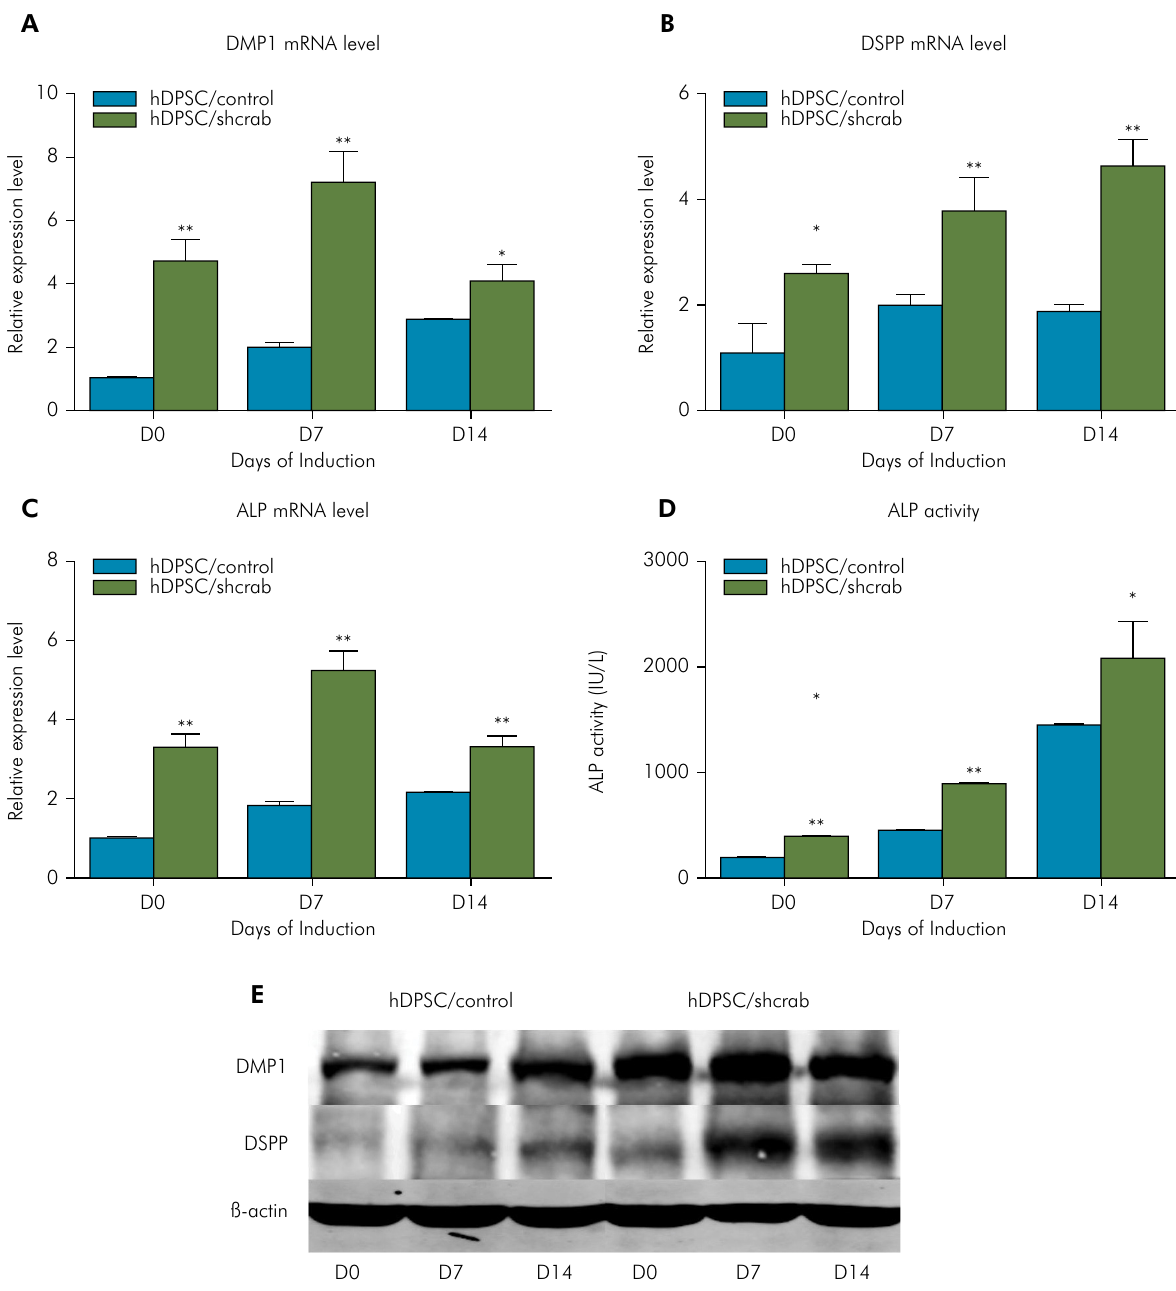
Figure 5. Inhibitory effect of CRABP2 on the odontoblastic differentiation of hDPSCs. A, B and C: mRNA level of DMP1, DSPP and ALP, respectively, following CRABP2 knockdown in hDPSCs during odontoblastic differentiation. D: ALP activity following CRABP2 knockdown. E: Protein levels of DMP1 and DSPP by western blot analysis. The data represent the mean ± SD of at least 3 independent